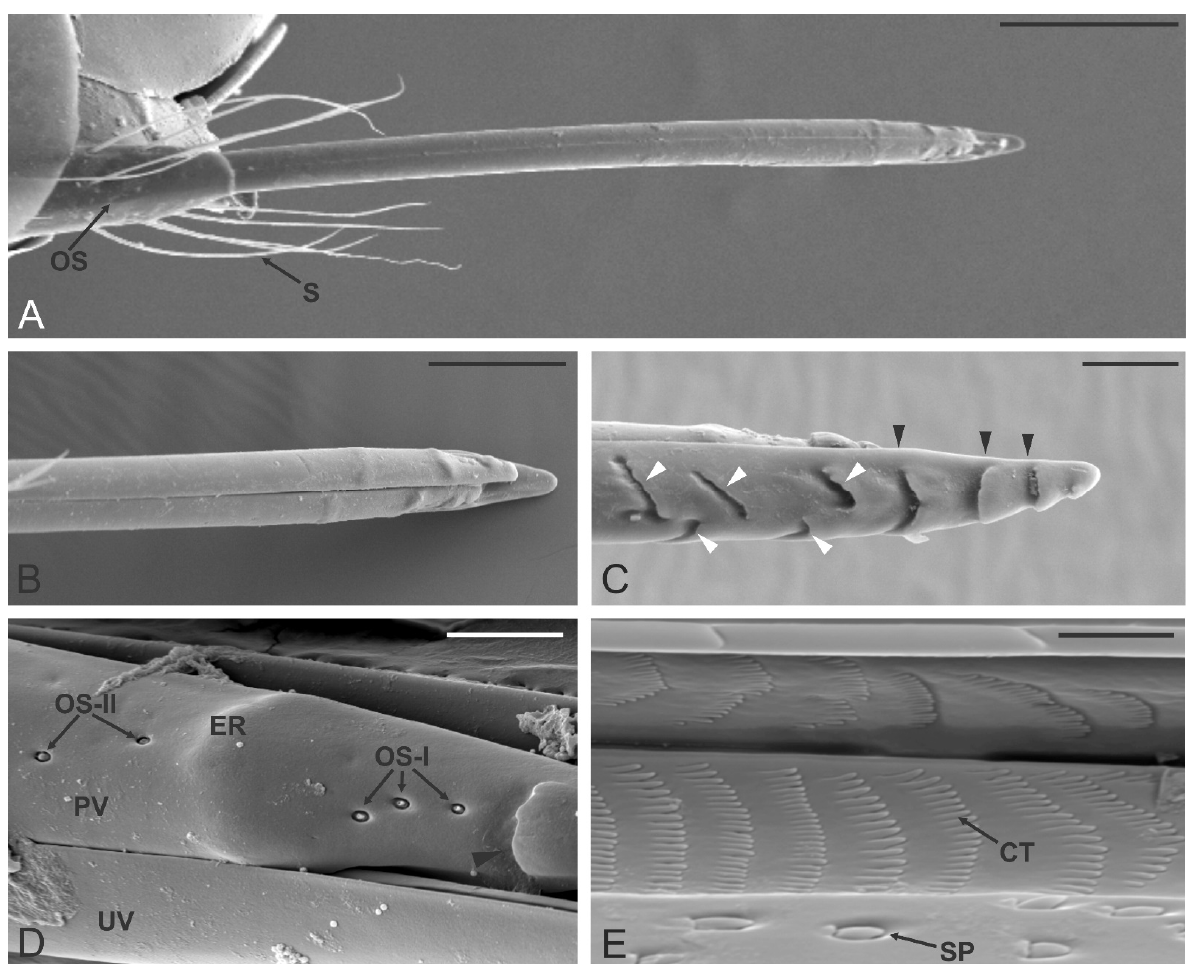
Figure 6. Dryocosmus kuriphilus ovipositor. ( A ) General view of the true ovipositor, at the base a tuft of elongated setae (S) and the third pair of valves (the ovipositor sheath OS) are visible. ( B , C ) SEM micrographs of the paired valves (in ( B )) and unpaired valve (in ( C )). The latter presents transverse furrows as a single (black arrowheads) or double slots (white arrowheads). ( D ) Close-up view of the apical part of one of the paired valves (PV) still attached to the unpaired valve (UV): note the presence of a single furrow (black arrowhead) and the elevated region (ER). The area delimited by the furrow and the elevated region presents three ovipositor sensilla type I (OS-I), while a couple of ovipositor sensilla type II (OS-II) are observed just behind the ER. ( E ) SEM micrograph showing a detail of the internal organization of the paired valve: several ctenidia (CT) arranged in the parallel pattern can be observed, as well as some scale-like pegs (SP) positioned on the sliding surface of the valve. Bar scale: ( A ), 100 µm; ( B ), 50 µm; ( C ), 20 µm; ( D ), 10 µm; ( E ), 5 µm.